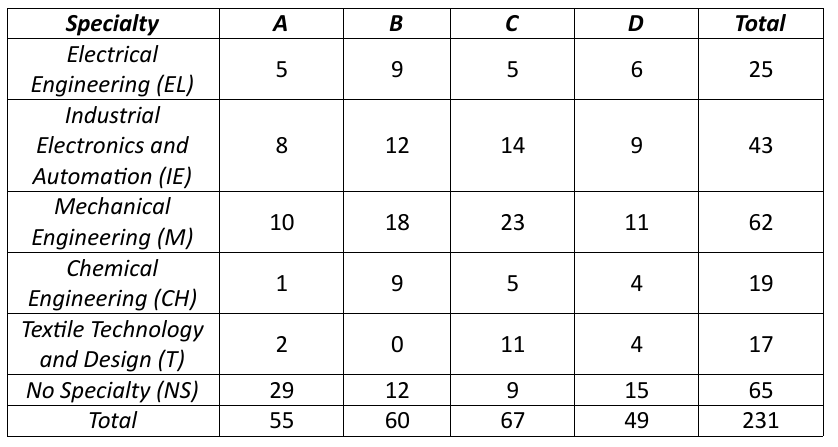
Table 3. Distributon of students by specialtes and groups. Academic year 2013/2014